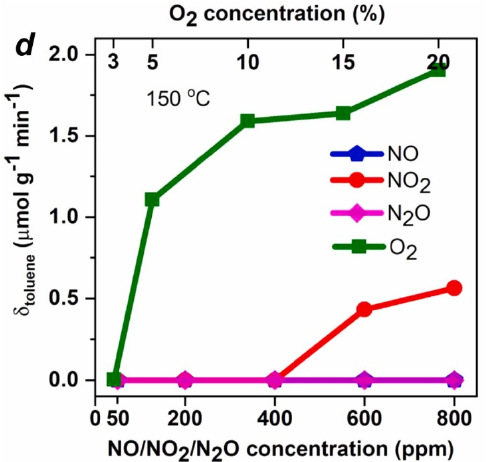
Figure 5. Effect of NO-NO 2 -N 2 O-O 2 content on the oxidation of toluene at 150 °C [85]. Copyright 2021, Elsevier B.V.